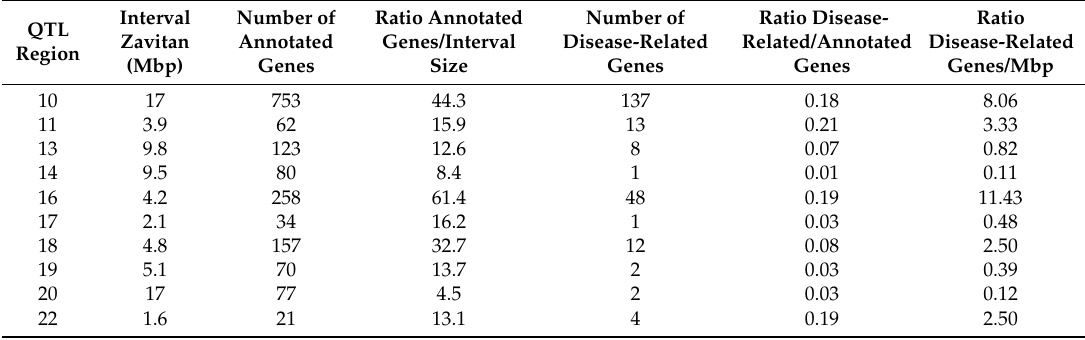
Table 2. Size and gene content of the physical regions corresponding to some of the quantitative trait loci (QTLs) identified in the present